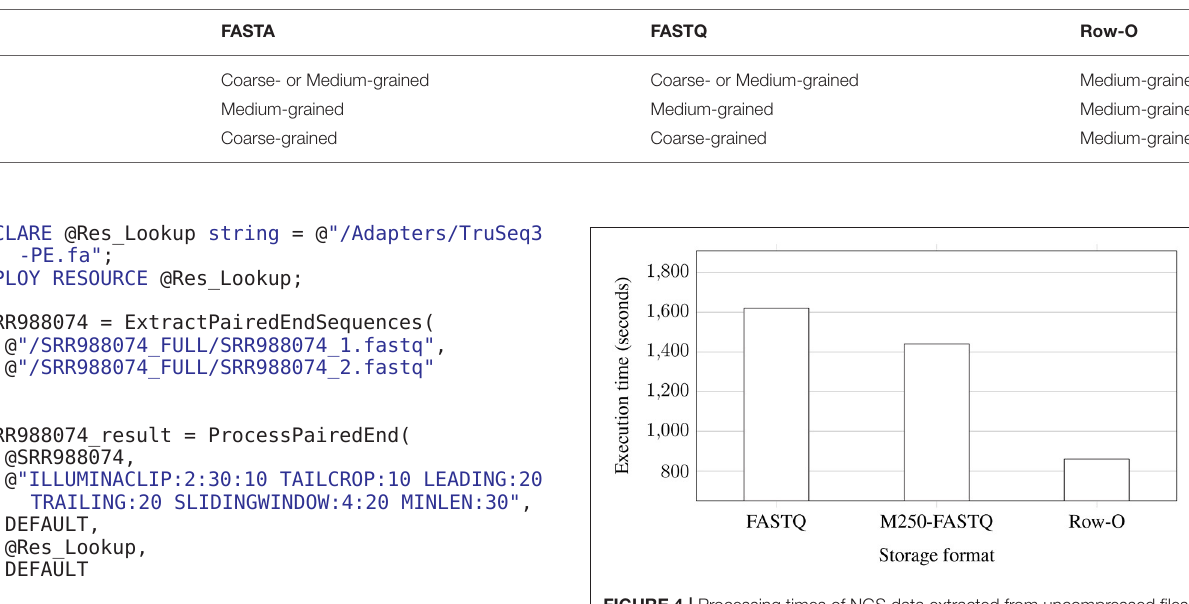
FIGURE 4 | Processing times of NGS data extracted from uncompressed files and saved to eight uncompressed FASTQ files (two files for each of the processed genomes) with 8 AUs for various storage formats: regular FASTQ, multiple 250 MB FASTQ (M250-FASTQ), and row-oriented (Row-O).